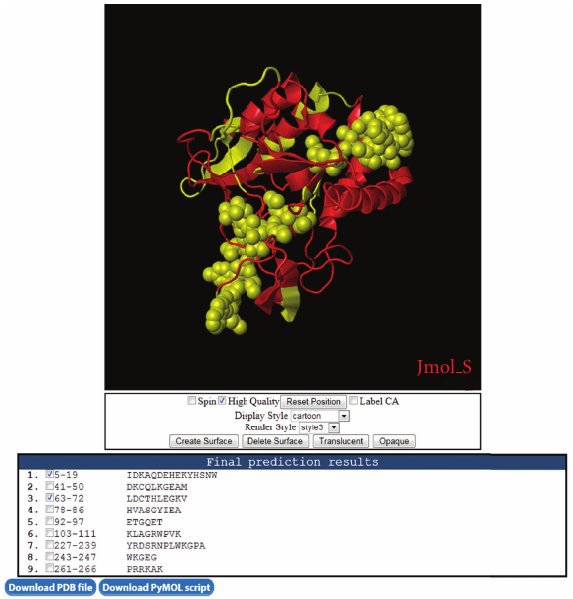
Figure 4: The predicted LEs of HIV integrase mapped onto a simulated 3D structure. The predicted epitopes are labeled in yellow, and the selected epitopes (number 1 and number 3) are shown in yellow spheres.